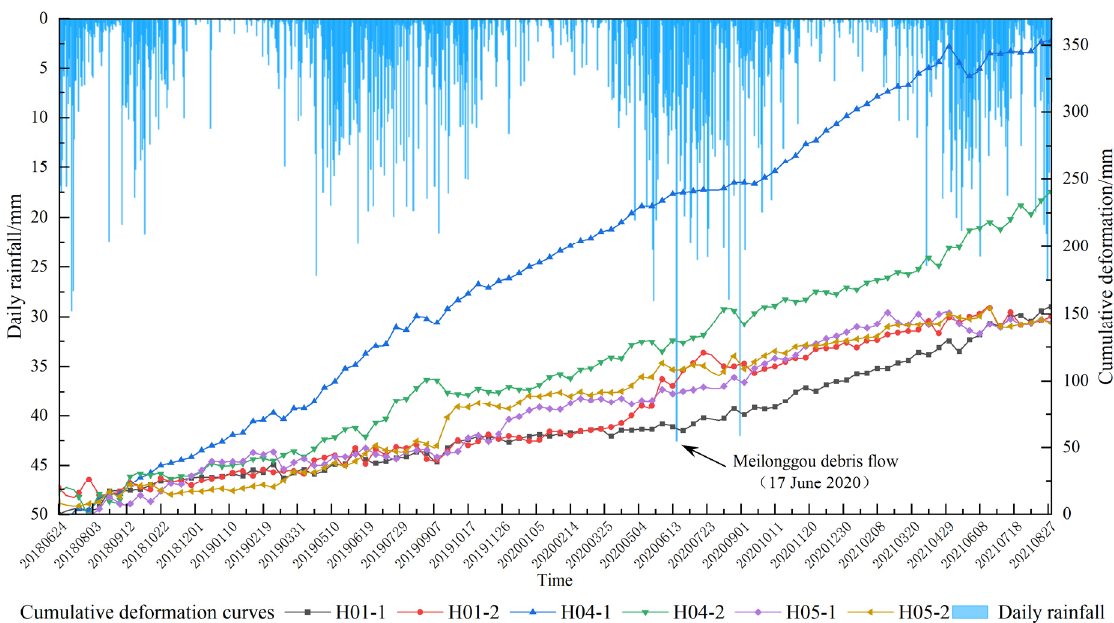
Figure 11. Daily precipitation and accumulative deformation curve of the Jiaju ancient landslide.